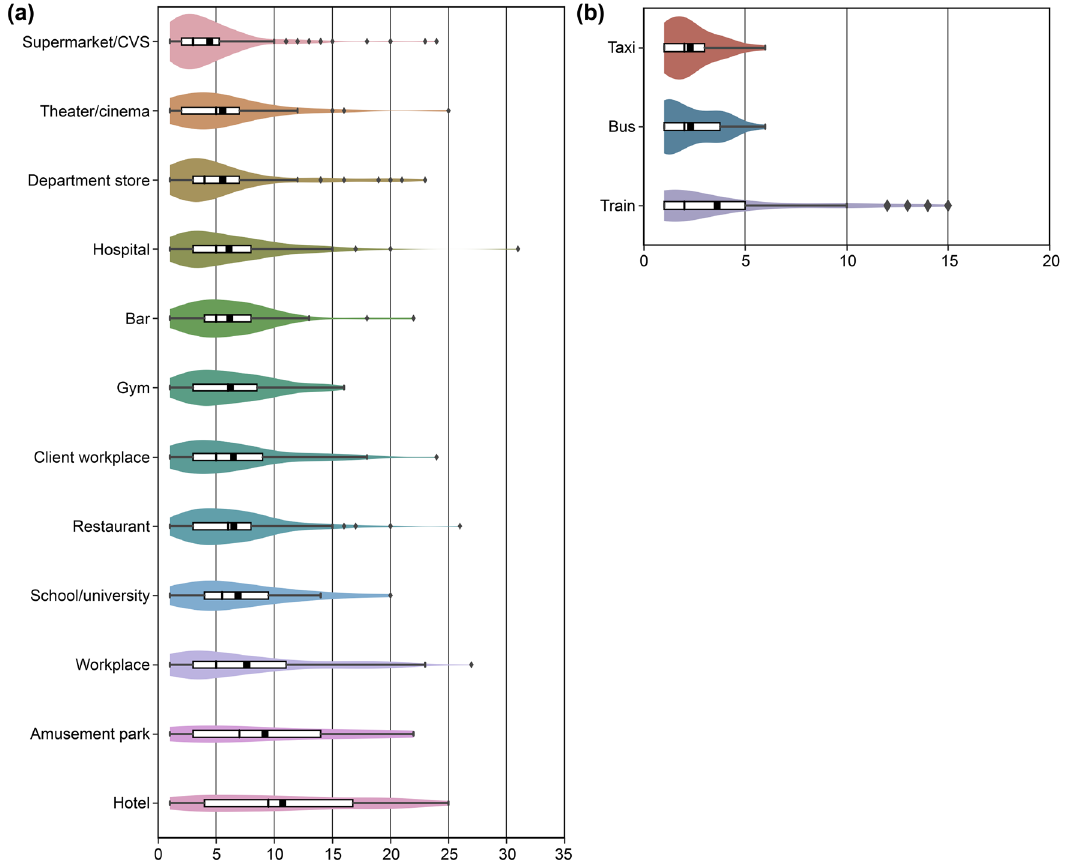
Figure 3. Box-and-whisker plots showing the number of objects that were touched ( a ) at each location and ( b ) per vehicle type. Here, the objects are placed in descending order according to their mean values. The left end of the white box represents the first quartile and the right end represents the third quartile, while the left end of the whisker represents the first quartile − 1.5 × IQR and the right end of the whisker represents the third quartile + 1.5 × IQR . The black square within the white box represents the mean value, and the black bar represents the median value. Diamonds indicate outliers. Each box-and-whisker plot is accompanied by a distribution